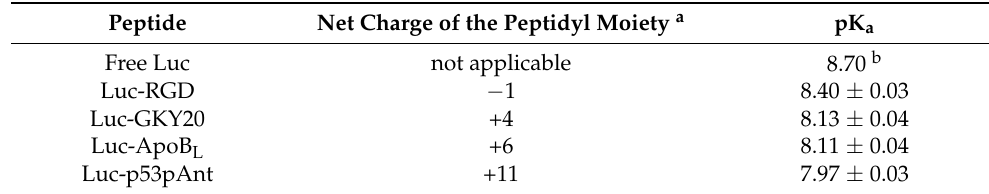
Table 3. pK a values of the phenolic group in Luc and Luc-labeled